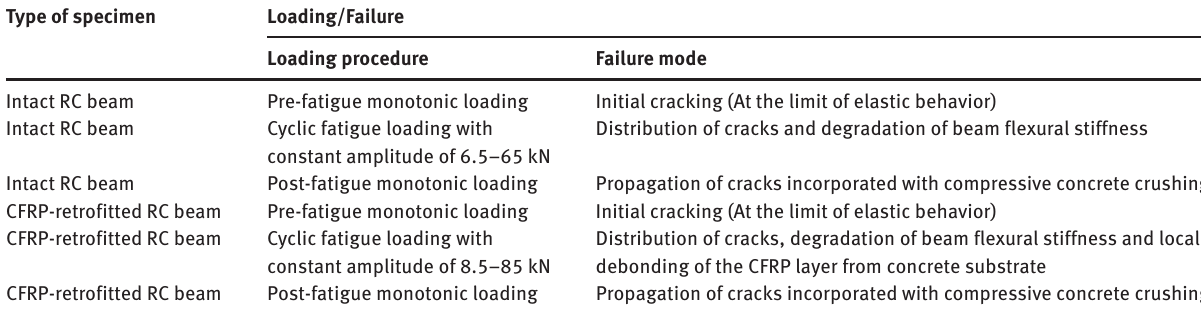
Table 2: Introduction of loading procedures and failure modes of tested specimens.